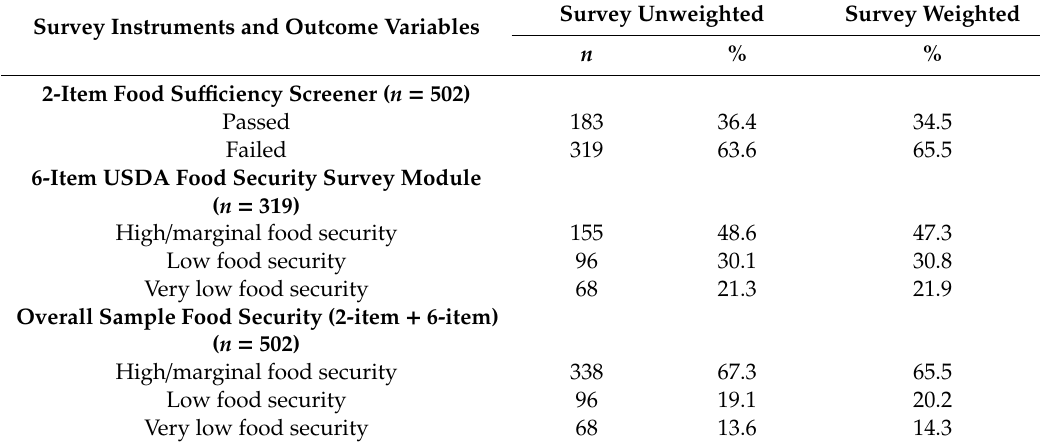
Table 3. Food security among survey respondents measured using a multistep food security